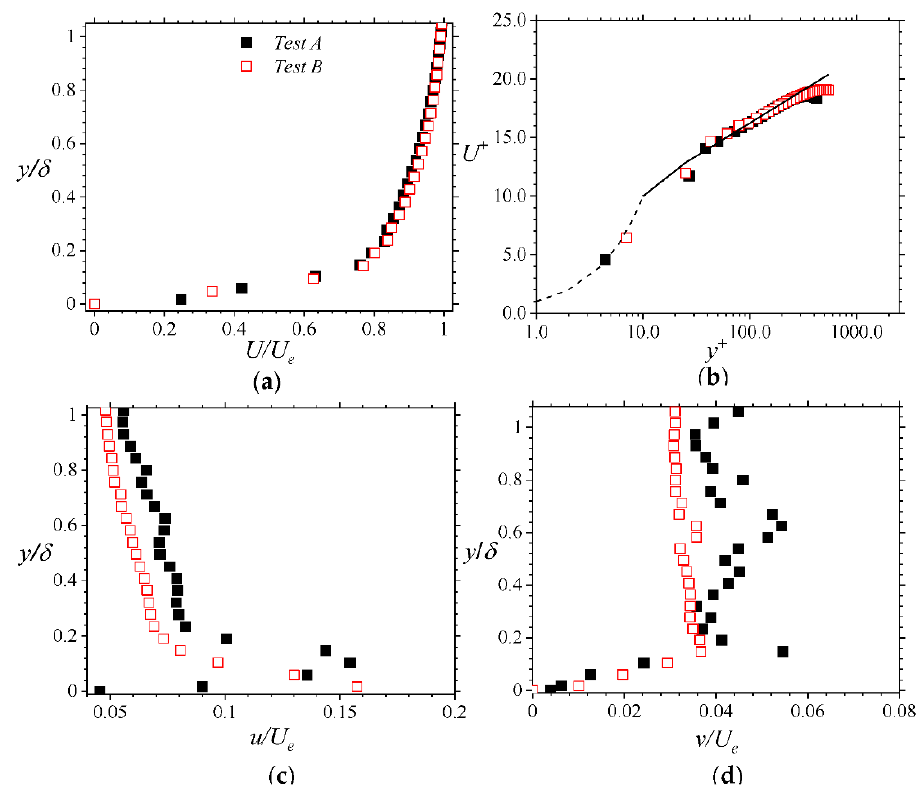
Figure 2. Boundary layer profiles of entry flow in the ( a ) outer and ( b ) inner coordinates for the two test cases. Plots in ( b , c ) are the turbulence intensities in the streamwise direction ( u ), and turbulence intensities in the wall-normal direction ( v ). Note that U e is the maximum velocity of the entry flow streamwise component of the mean velocity ( U ); U + = U / U τ where U τ is the friction velocity, and y + = y U τ / ν where ν is the kinematic viscosity of the fluid. Note that the legend shown in ( a ) applies to ( b – d ).